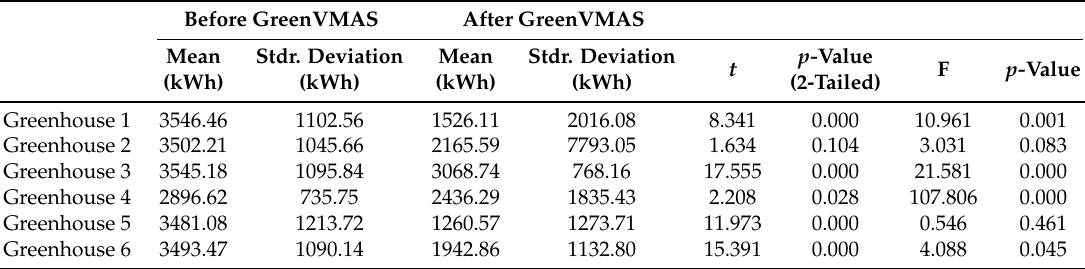
Table 8. Results of the Student’s t -test and Levene’s test performed in autumn tomato cultivation. Difference of means (electrical consumption in kWh) and variances between the data obtained before and after using GreenVMAS. Before GreenVMAS After GreenVMAS